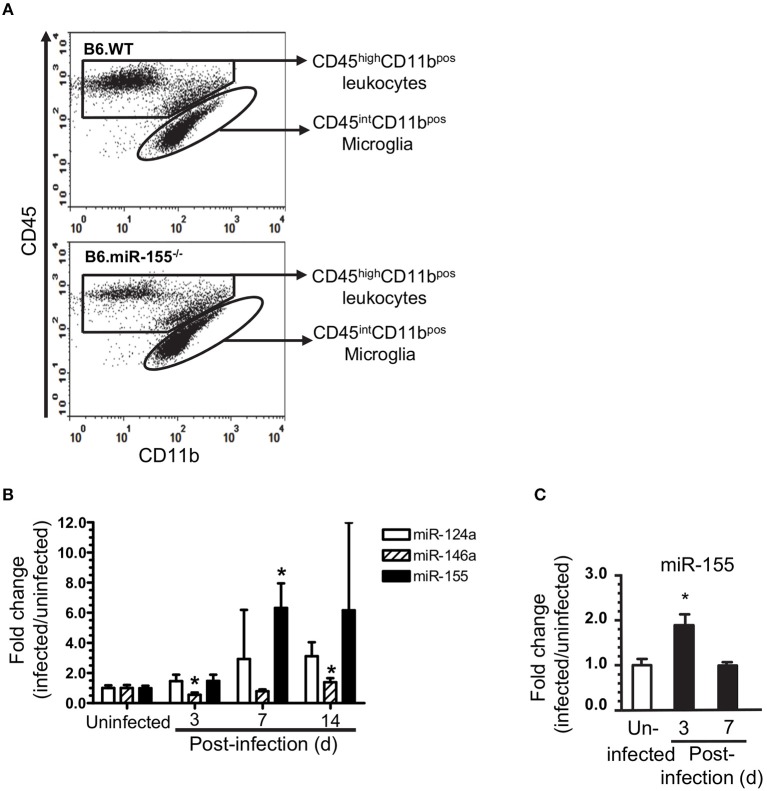
L. monocytogenes infection upregulates microglial miR-155. Brain leukocytes were isolated from uninfected and infected age and sex-matched B6.WT and B6.miR-155−/− mice described in Figure 2A. Cells from 2 to 3 mice of each genotype per time point were pooled. CD11bpos cells were collected from each cell pool by immunomagnetic sorting then underwent flow cytometric sorting to collect specific populations. Microglia, defined as CD45intCD11bpos cells, were collected from uninfected mice, and mice 3, 7, and 14 d p.i. In contrast, CD45highCD11bpos cells were collected at 7 d p.i. only. (A) Representative dot plots show sort windows 7 d p.i. (B) miR expression in sorted CD45intCD11bpos microglia was measured by qPCR and normalized to snoRNA135. Results shown are fold change + SD miR expression (infected/uninfected) in 3–4 cell pools comprised of cells from 2 to 3 mice per time point. *p < 0.05 compared with uninfected mice by one-way ANOVA with Dunnett's post-test. (C) miR-155 expression was determined by qPCR in CD11bpos bone marrow cells and normalized to snoRNA. Results presented are the mean + SD fold change normalized miR-155 (infected/uninfected) from 4 individual mice of either genotype per time point. *p < 0.05 compared with uninfected control by 1-way ANOVA with Dunnett's post-test.